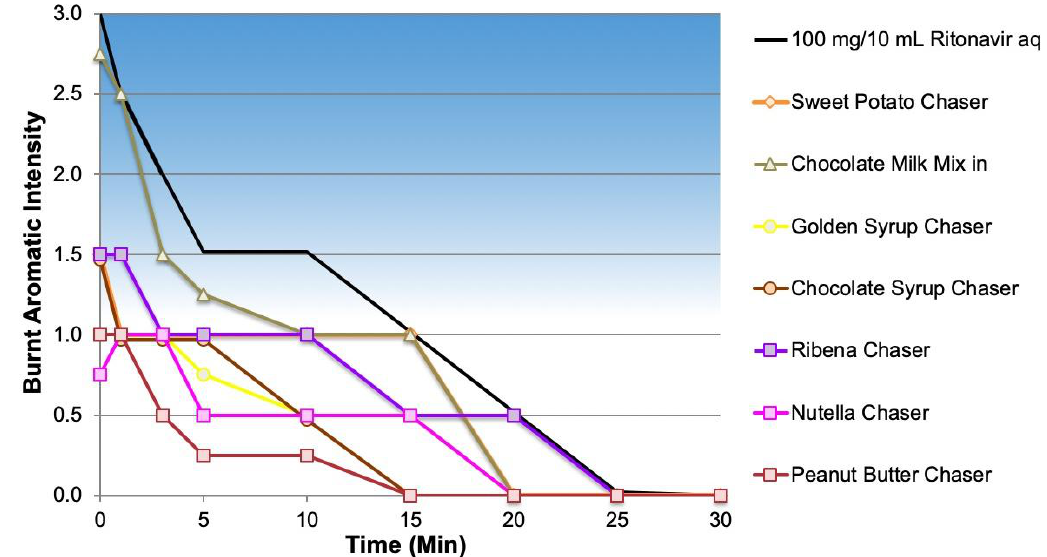
Figure 6. Burnt aromatics profile for NOP with food chasers.